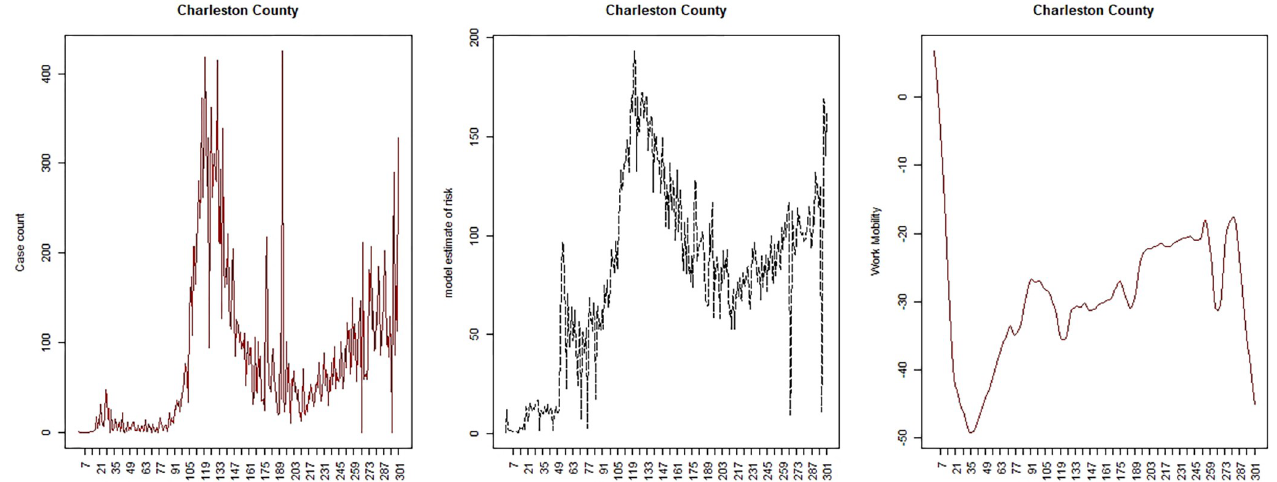
Fig 10. SC: Charleston county case count, modelled risk, work mobility profile.